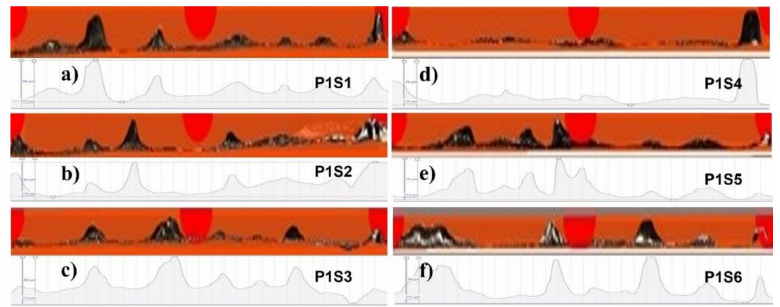
Figure 18. Peripheral morphology of ( a ) P1S1, ( b ) P1S2, ( c ) P1S3, ( d ) P1S4, ( e ) P1S5, and ( f )